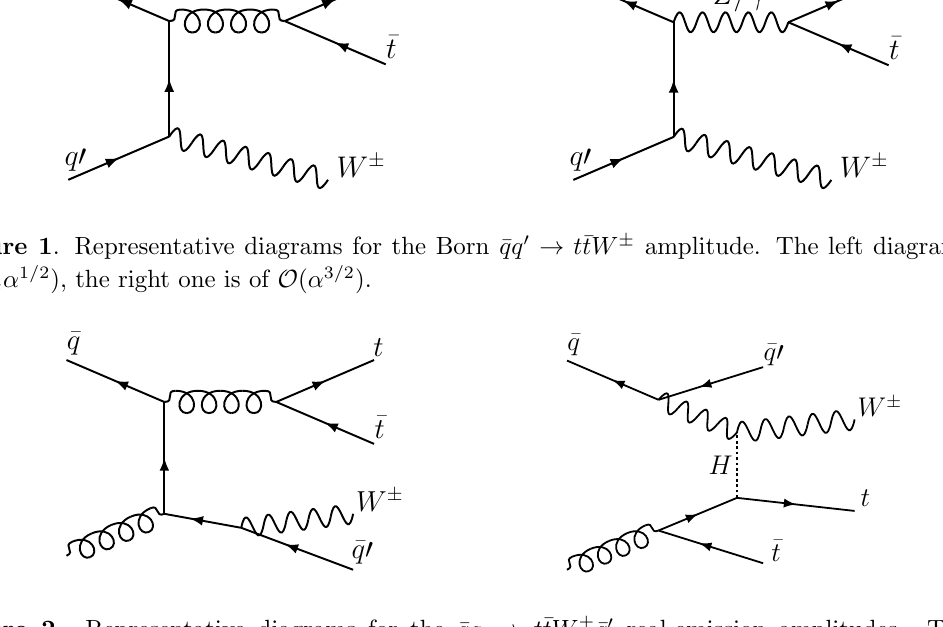
( t (cid:22) t ) =m 2 ) terms in the NLO 1 contribution. The T W